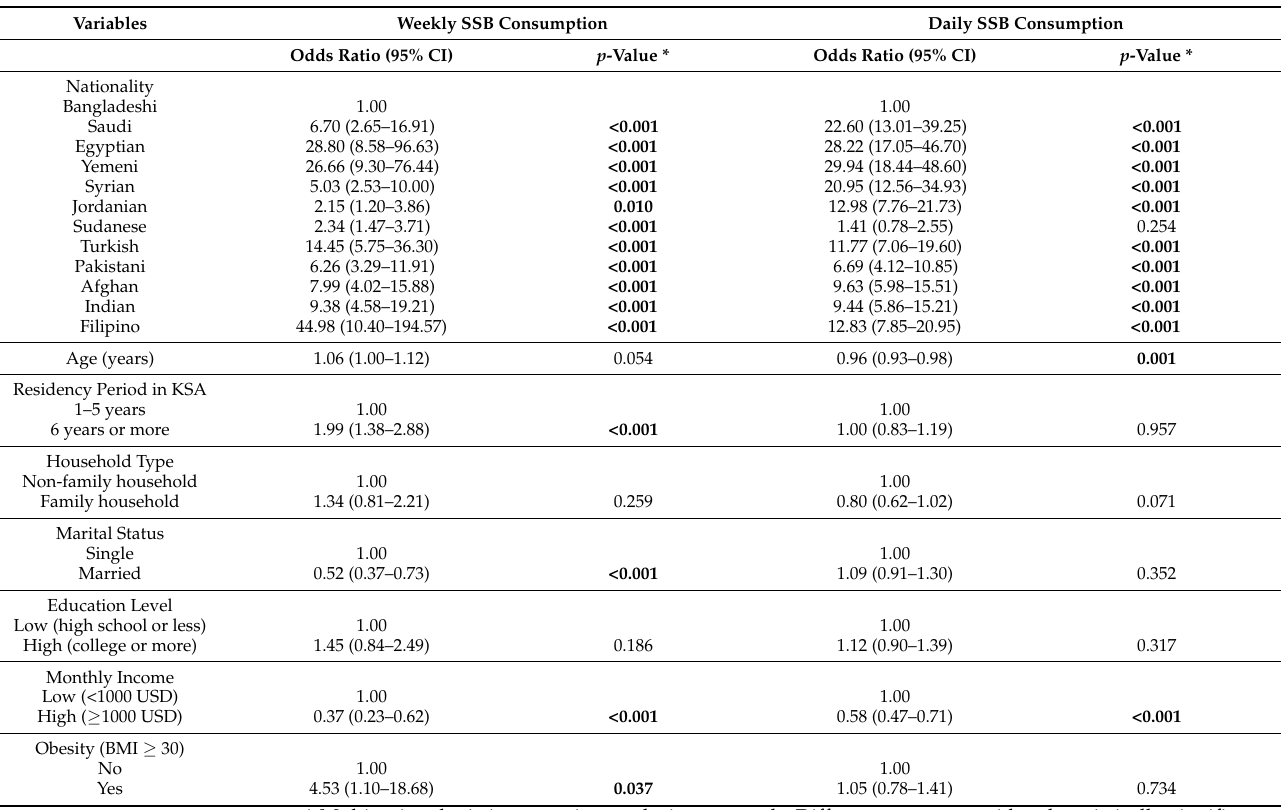
Table 3. Likelihoods of weekly and daily sugar-sweetened beverage (SSB) consumption among study participants for sociodemographic characteristics and